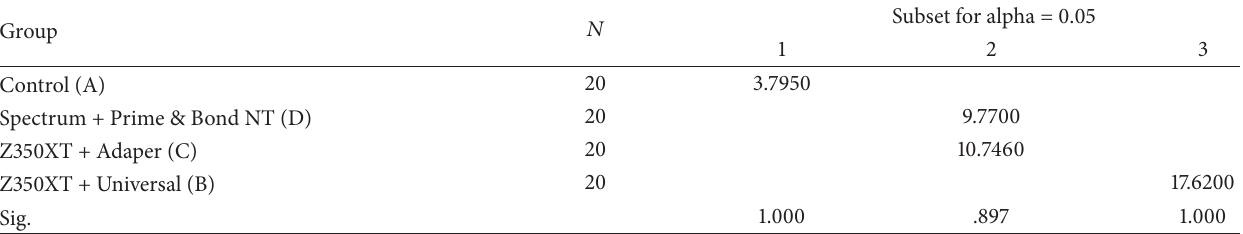
Subset for alpha =